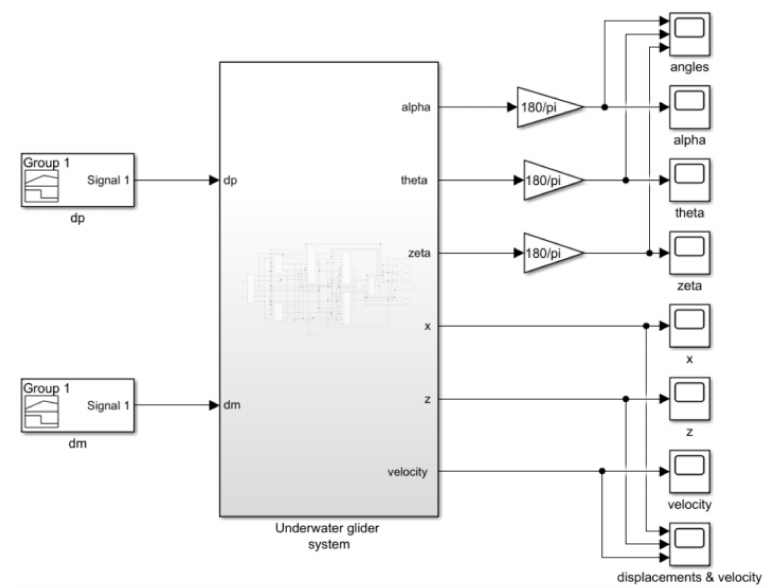
Figure 6. Simulation structure.